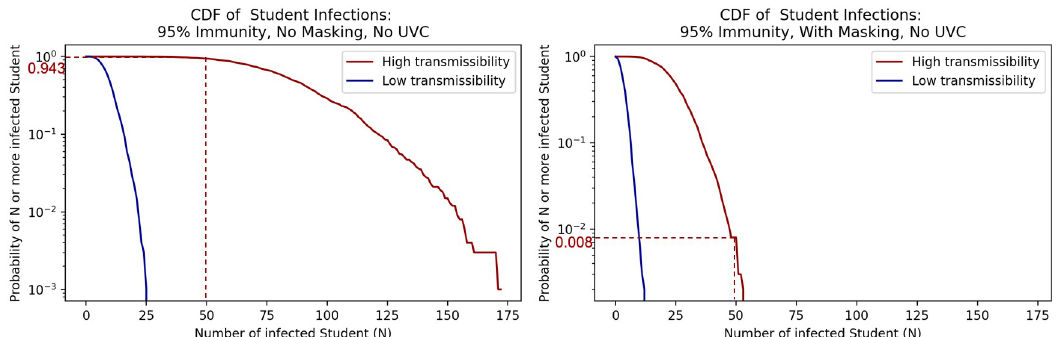
Fig 2. Inverse cumulative density functions for the total number of students infected under the different scenarios. Each graph shows the curve of the probability of exceeding a given number of infections.